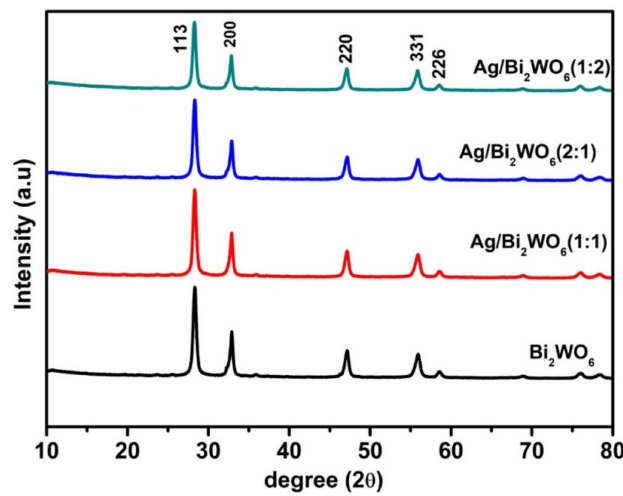
Figure 3. XRD spectra of pure Bi 2 WO 6 and Ag/Bi 2 WO 6 (1:1, 1:2 and 2:1).